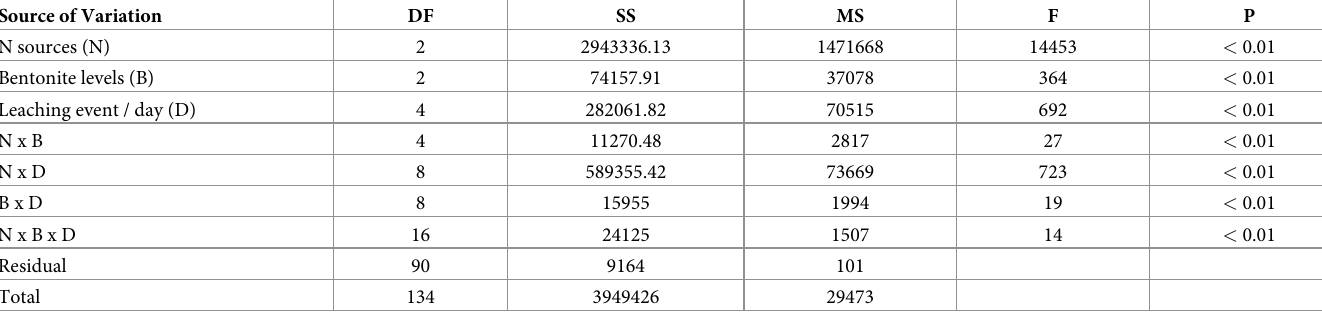
Table 2. Summary ANOVA on effect of bentonite and N sources on NO3-1 leaching at different leaching events. Source of Variation DF